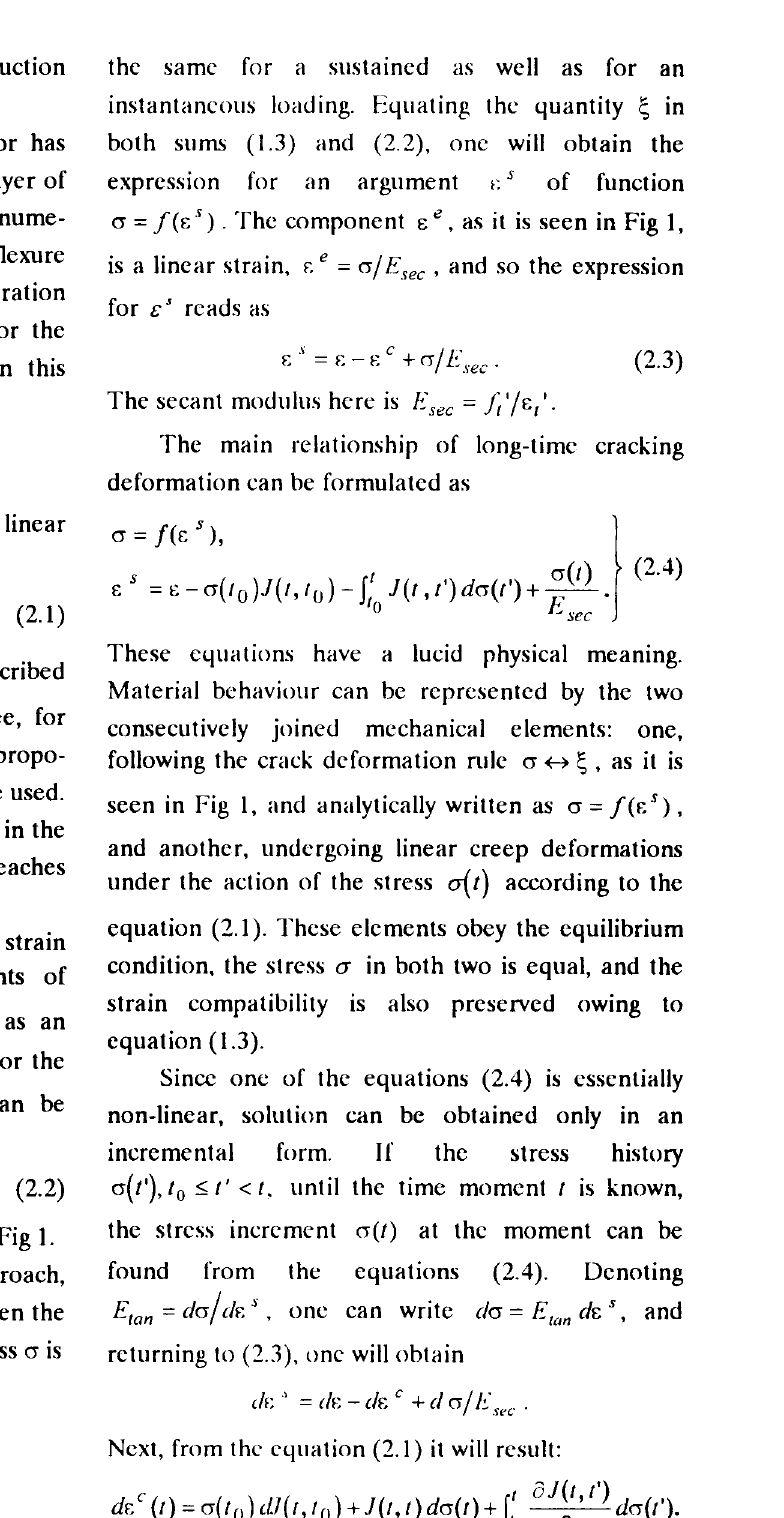
Fig 1. Stress-strain relationship for short-time tension. The clastic and crack components of the total strain are